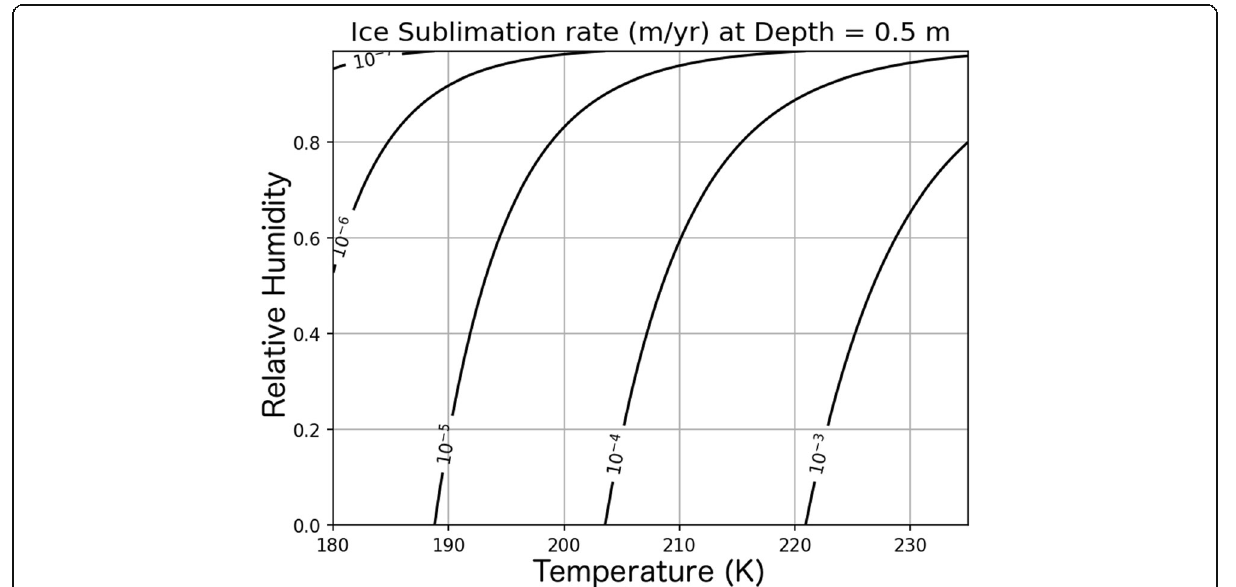
Fig. 8 Dependence of ice ablation on temperature and relative humidity. Contours give sublimation rate for a given temperature ( x -axis) and relative humidity (RH; y -axis) assuming an ice burial depth of 0.5 m based on Eq. 5. The model simulation assumes RH = 0.01 but allows temperature to vary with time and location along the flow line depending on obliquity and local slope, respectively